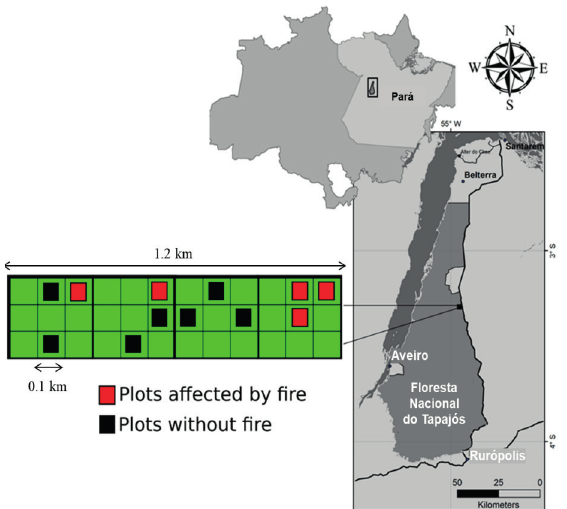
Figure 1 - Location of the T0 plots (black squares) and T1 (plots affected by fire), installed in an area of 36 hectares of dense ombrophylous forest, with no history of logging, in the Floresta Nacional do Tapajós, Pará State,